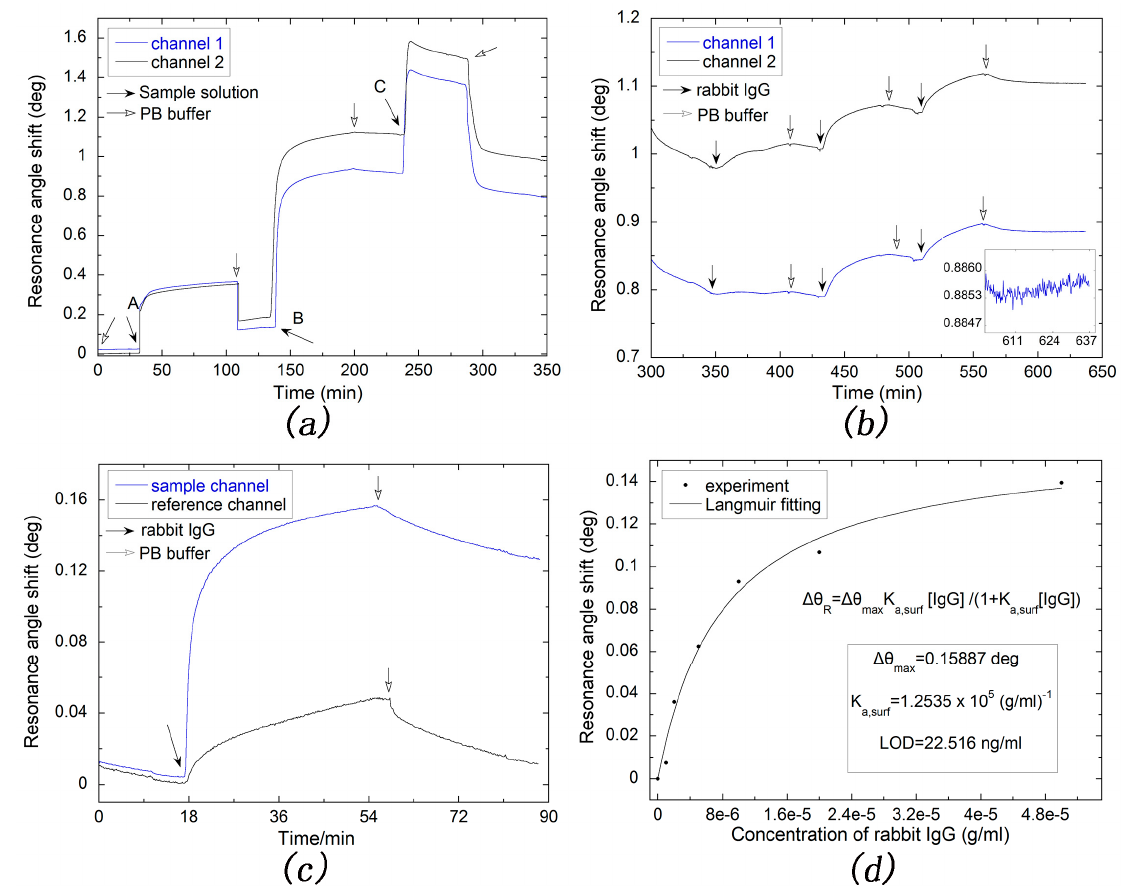
Figure 7. ( a ) Real-time monitoring the modification of silver-based SPR sensor with A is 10 mg/mL EDC solution, B is 50 ug/mL GAR IgG and C is 3% BSA solution; ( b ) The resonance angle shift for detecting different concentrations of rabbit IgG (1, 5, 20 μ g/mL for channel 1 and 2, 10, 50 μ g/mL for channel 2) and the inset shows resonance angle shift curve after detecting rabbit IgG; ( c ) Test on influence of nonspecific adsorption; ( d ) Langmuir fitting with data measured from ( b ).